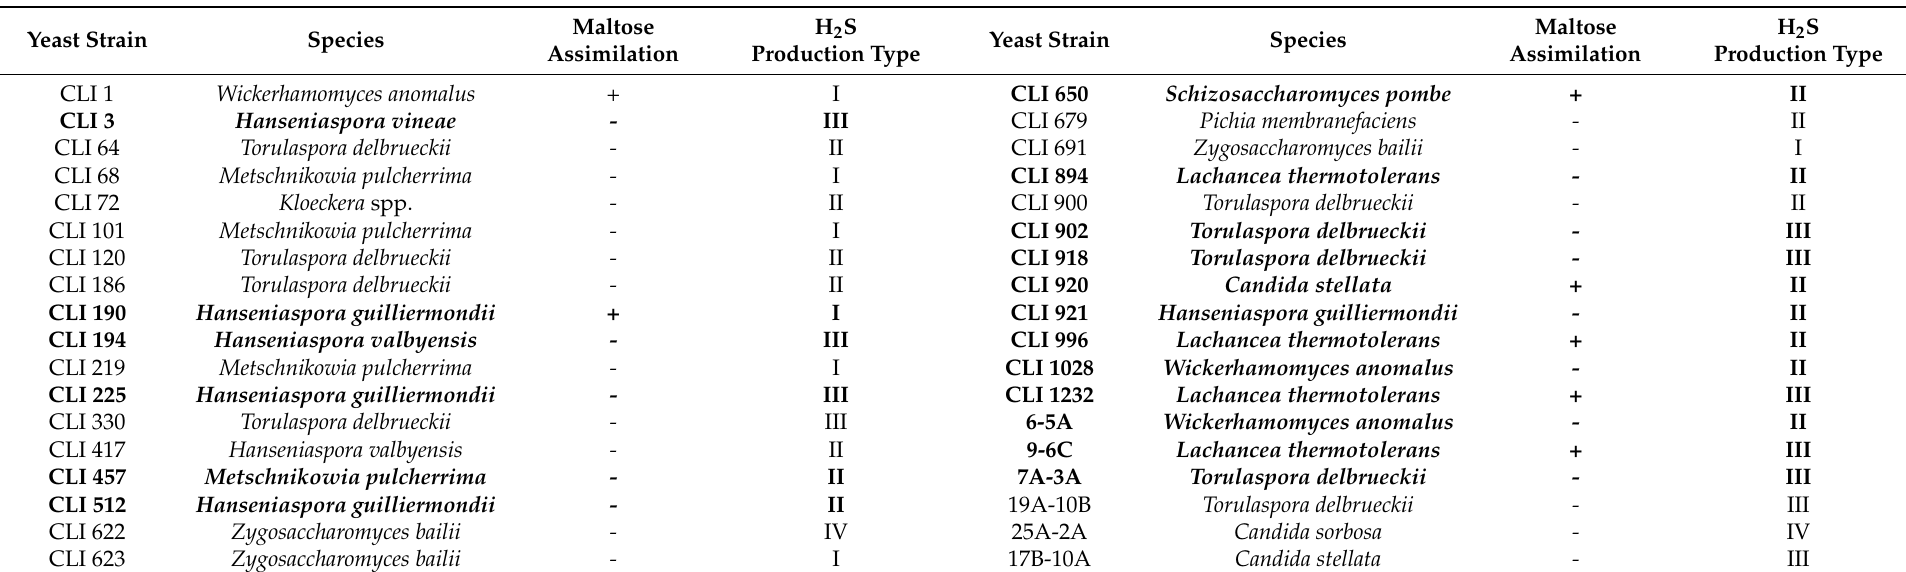
Yeast strains able to assimilate maltose are represented by “+”, while yeast strains not able to assimilate maltose are represented by “-”. Maltose assimilation is indicated as: Type I for low-null production; Type II for moderate production; Type III for high production; and Type IV for very high production. Strains marked in bold were preselected after the qualitative analysis of H 2 S, maltose metabolism and fermentative behaviour in 100